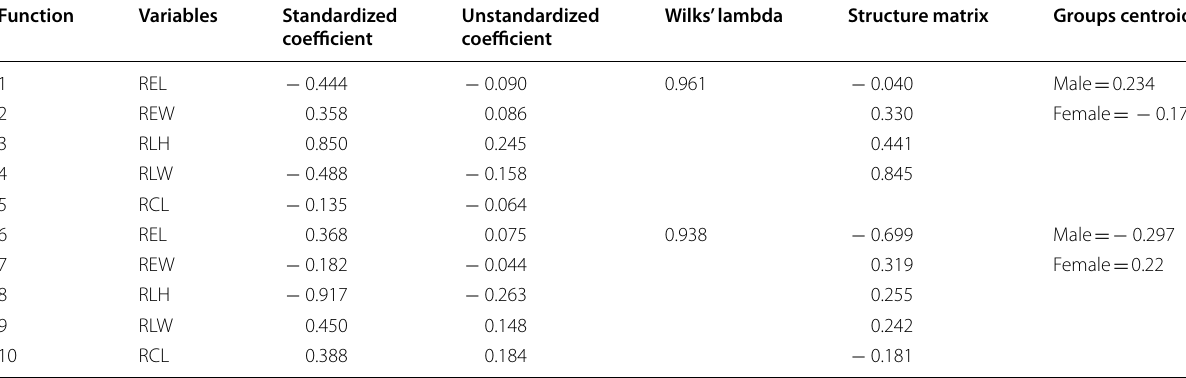
R, right; L, left; EL, ear length; EW, ear width; LH, lobule height; LW, lobule width, CL, concha length